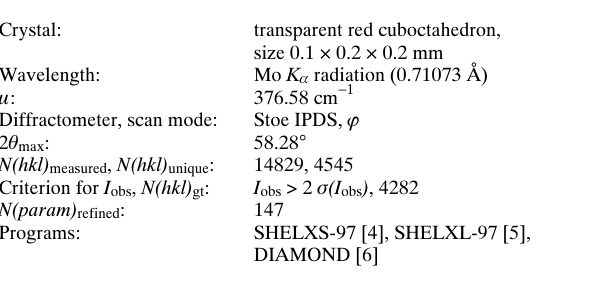
Table 3. Data collection and handling.